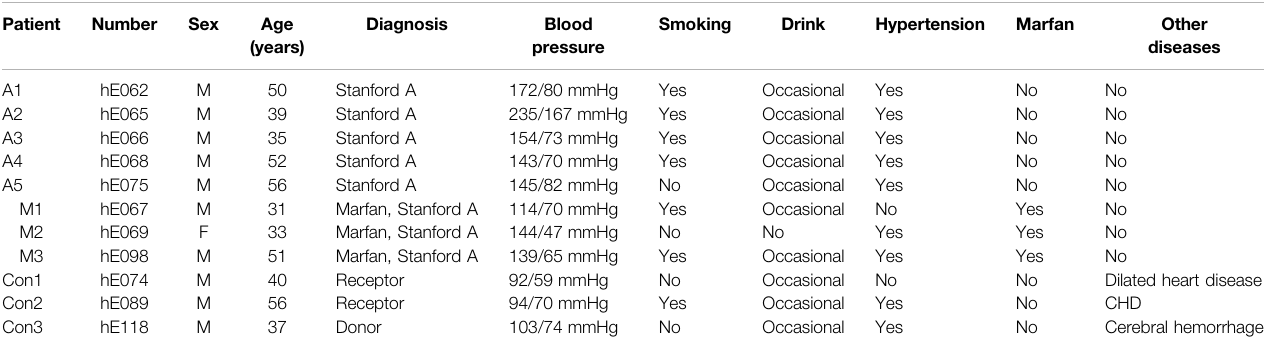
TABLE 2 | Patient information for aortic samples ( n = 11).